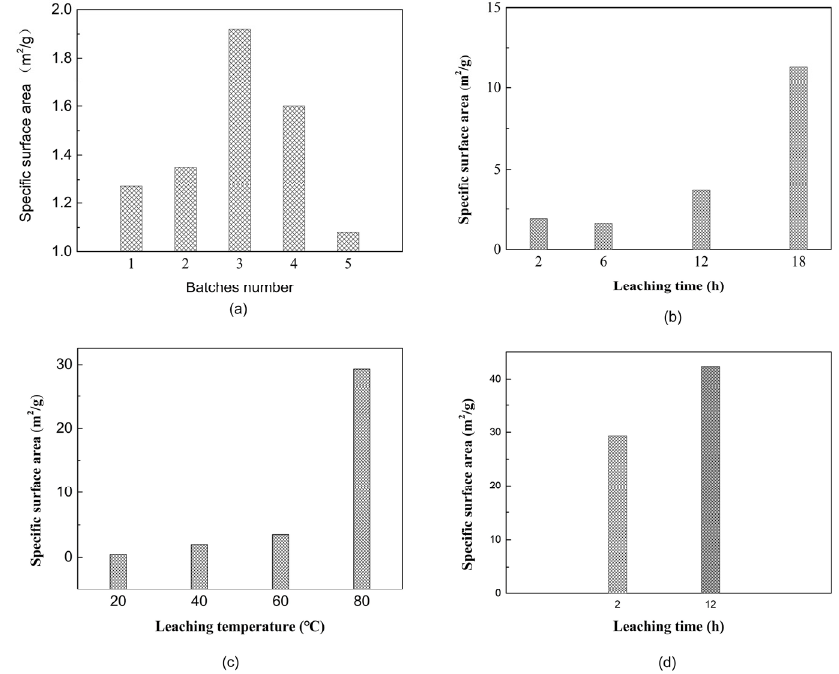
Figure 3. ( a ) Specific surface areas of the different batches leached at 40 ◦ C for 2 h. ( b ) Specific surface areas of batch 3 at 40 ◦ C for leaching times of 2, 6, 12, and 18 h. ( c ) Specific surface areas of batch 3 leached at 20, 40, 60, and 80 ◦ C for 2 h. ( d ) Specific surface areas of batch 3 leached at 80 ◦ C for 2 and 12 h.